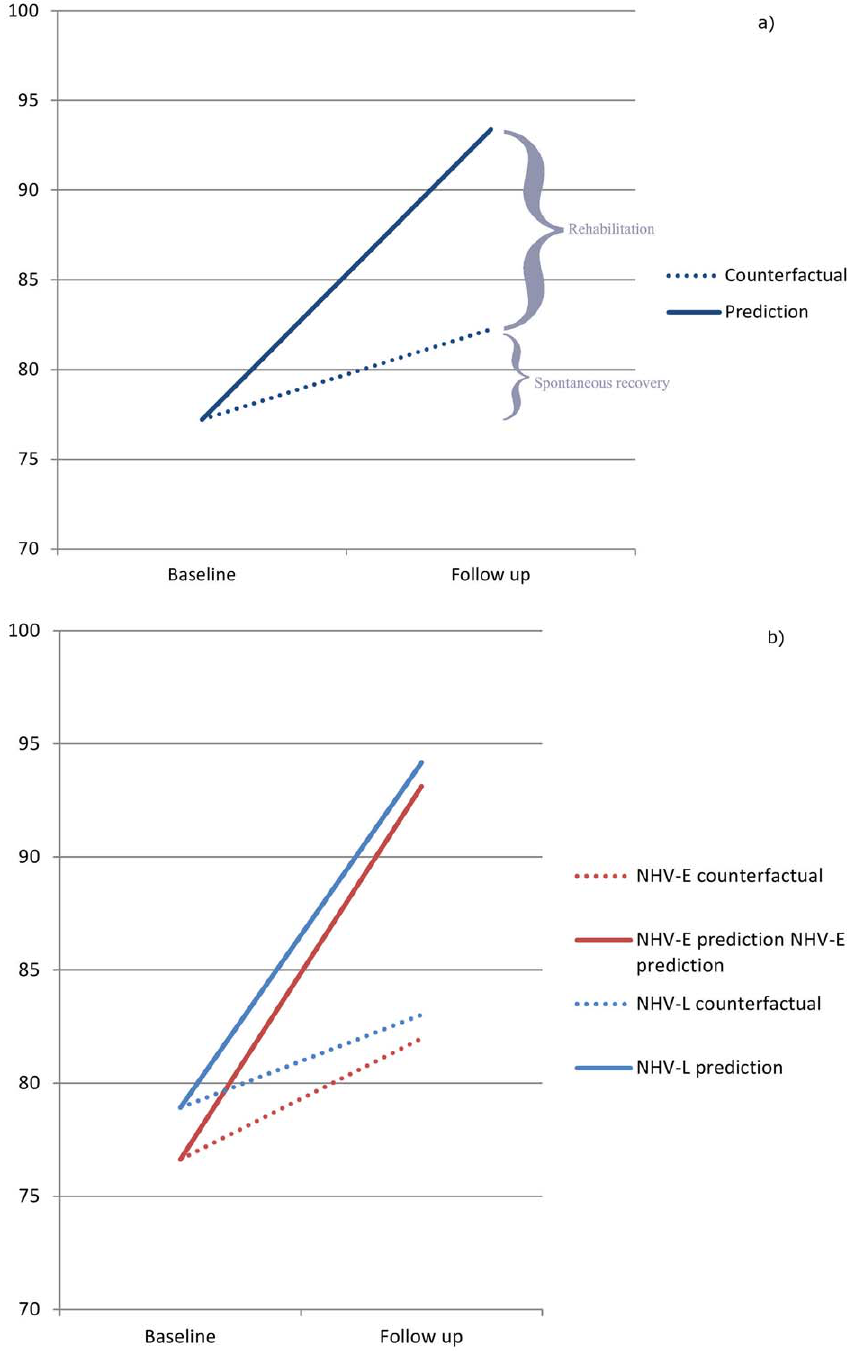
Figure 5. Relative combined effect of NHV and recovery over time (a) and individual effects of NHV-E and NHV-L and recovery over time